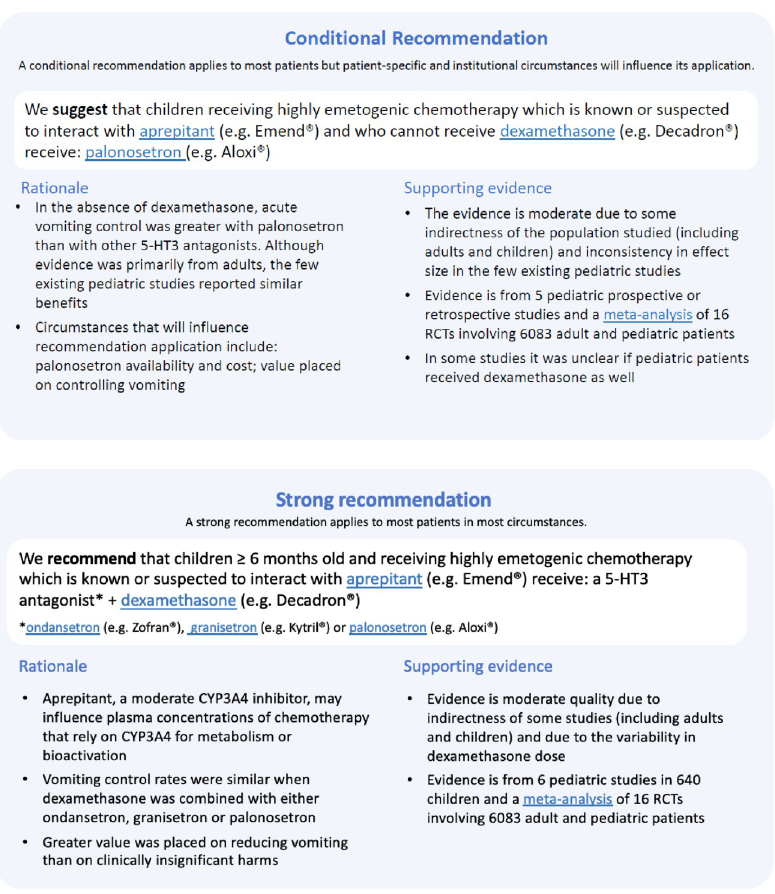
Fig 1. Final recommendation summary format: Chemotherapy-induced nausea and vomiting. Factors influencing understanding of the recommendation summaries.